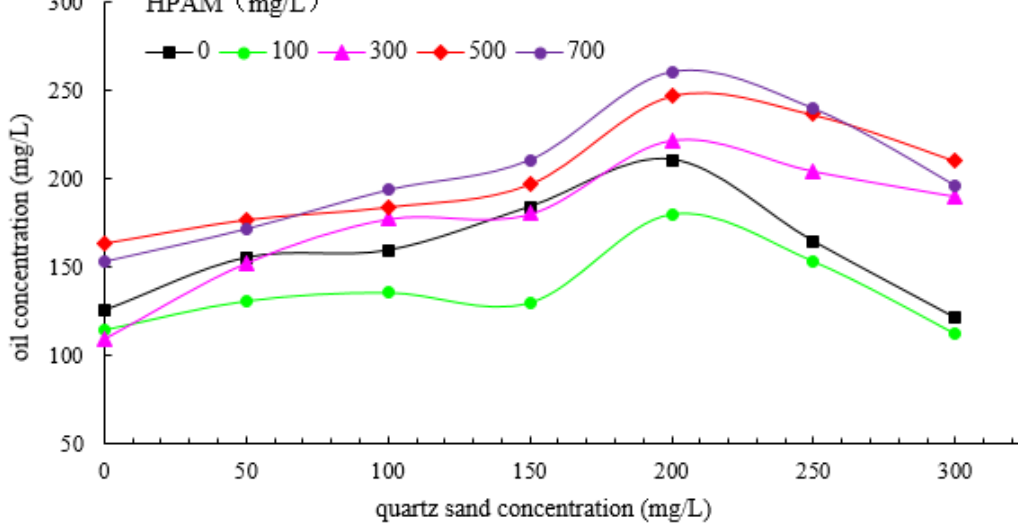
Figure 5. The synergetic effect of polymer and quartz sand particles on oil–water separation (alkali concentration 600 mg/L, surfactant concentration 200 mg/L).